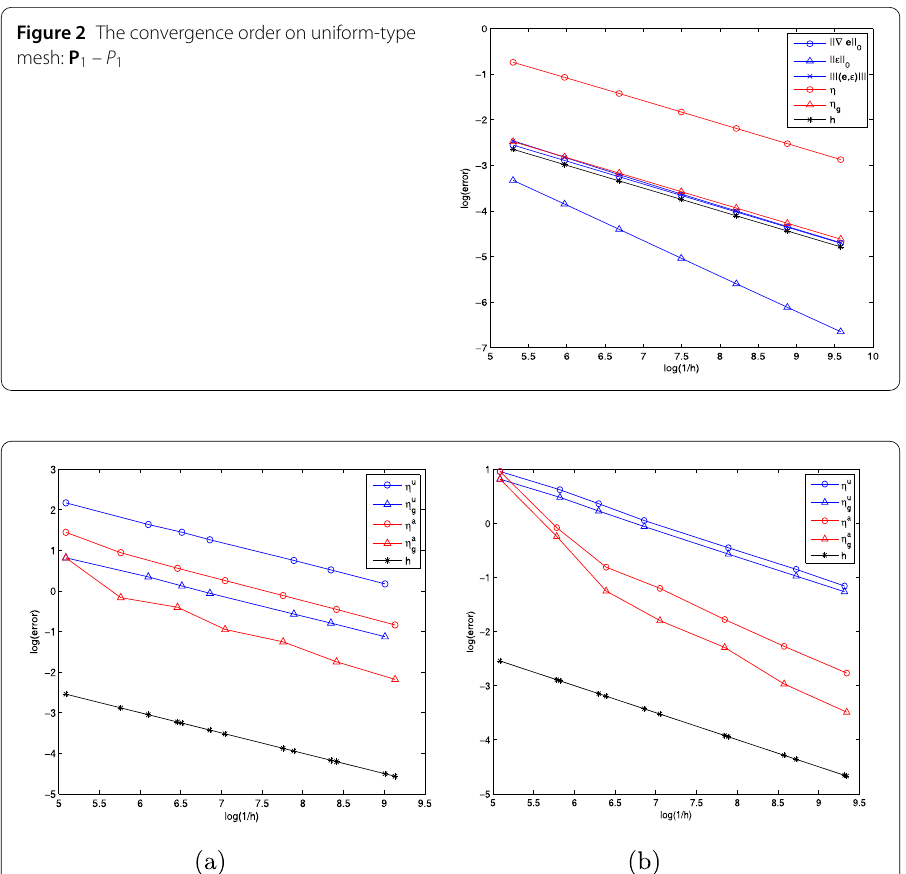
Figure 3 The convergence rate of adaptive and uniform refinements for the problem on L-shape domain with slip boundary condition: g is continuous at (0,0). ( a ): P 1 – P 0 ; ( b ): P 1 – P 1